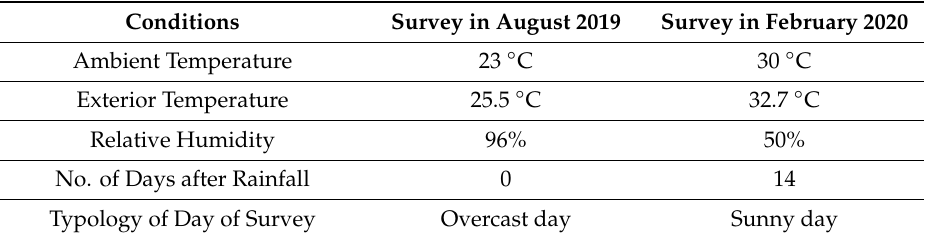
Table 1. Environmental parameters mapped for the thermal